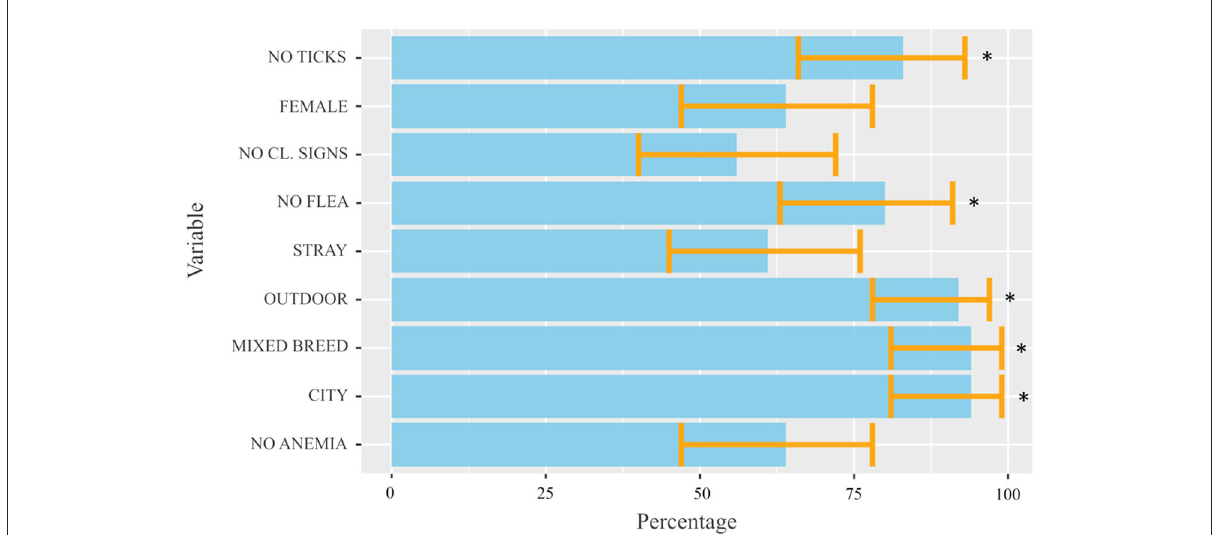
FIGURE3 Estimated proportions for each dichotomous variable obtained by the one-sample proportional test from cats infected with Cytauxzoon spp. included in the study. The light blue bars represent the estimated proportions for each dichotomous variable obtained by the one-sample proportional test, considering a true proportion not equal to 0.5 as an alternative hypothesis. The orange lines (error bars) represent the width of the 95% IC calculated for each variable and provide interval estimations (and the uncertainty of the measurement) for the real population proportion of each variable. The P -value < 0.05 was considered significant and was indicated by *. CL,